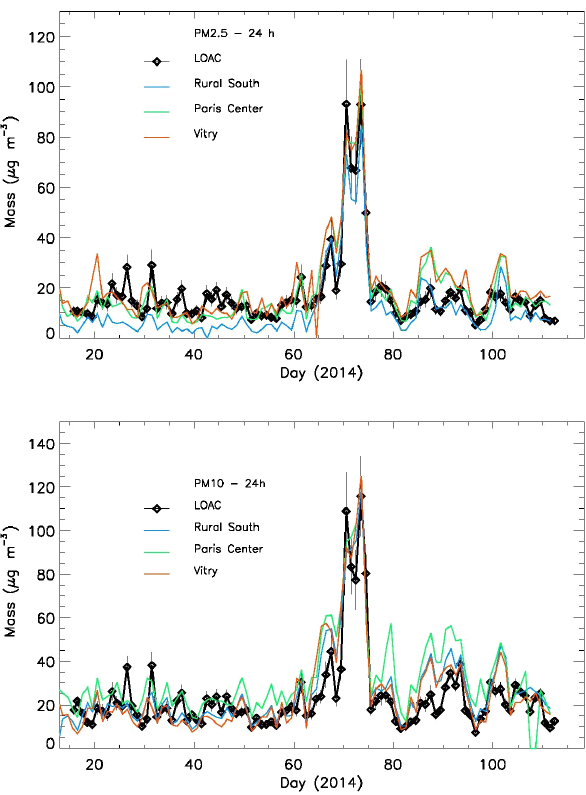
Figure 22. PM 2 . 5 (upper panel) and PM 10 (lower panel) LOAC mass concentrations measurements in 2013 during the ParisFog campaign at SIRTA Observatory in Palaiseau, south of Paris, and at the OAG in the south-west of Paris, and comparison with refer- ence TEOM data from the Airparif air quality monitoring network.